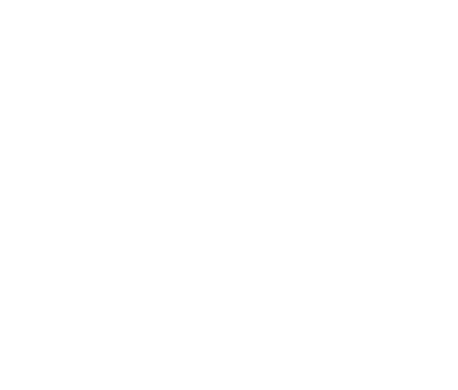
Figure 5. Distribution of the DMD gene sub-type point mutations in the analyzed patients with DMD or BMD.